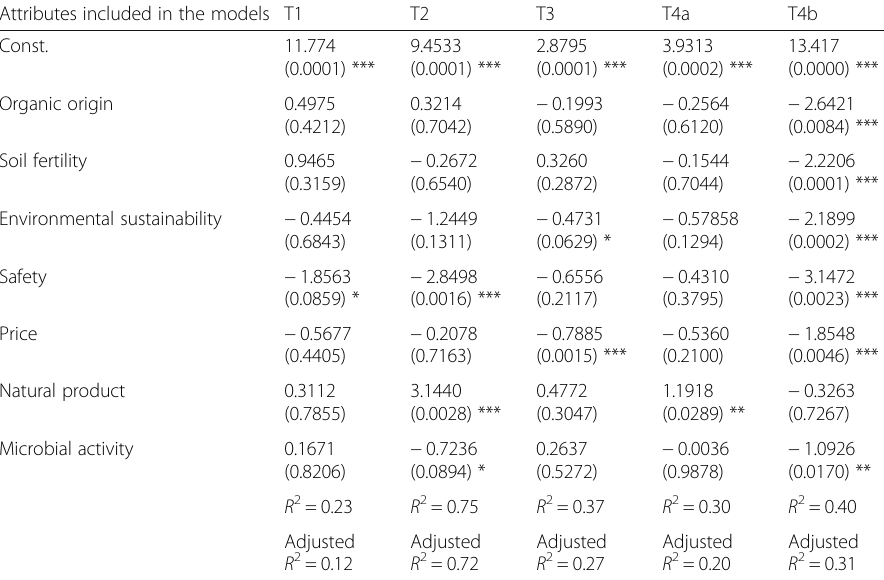
Table 6 OLS regression of attributes affecting willingness to pay for digestate Attributes included in the models T1 T2 T3 T4a T4b Const. 11.774 Organic origin 0.4975 Soil fertility 0.9465 Environmental sustainability − 0.4454 Safety − 1.8563 Price − 0.5677 Natural product 0.3112 Microbial activity 0.1671